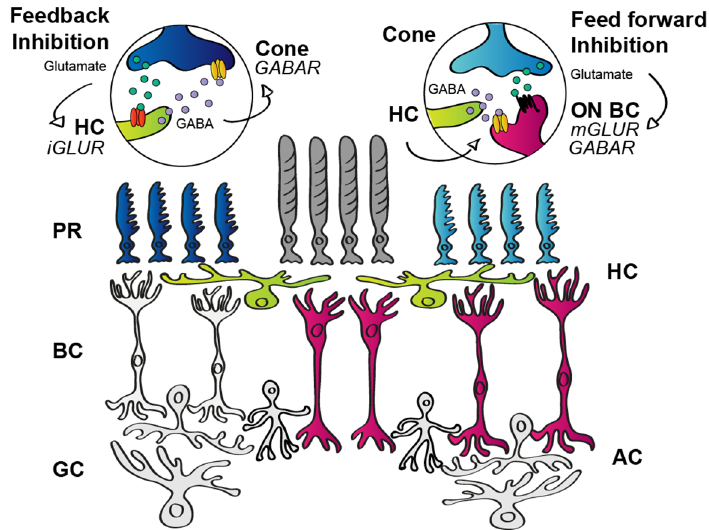
Figure 4. Inhibitory mechanisms in the outer retina. Photoreceptors (PR; dark grey, dark and light blue) release glutamate that binds to ionotropic glutamate receptors located on the postsynaptic dendritic surfaces of horizontal cells (HC, green). HCs in turn release GABA as an inhibitory transmitter and provide feedback inhibition to PRs (left side of the scheme—note that HC to rod BC feedback inhibition is not shown in the diagram but exists as well) and feedforward inhibition to BCs (magenta—right half of the scheme). Amacrine cells (AC) and ganglion cells (GC) are also represented in the retinal